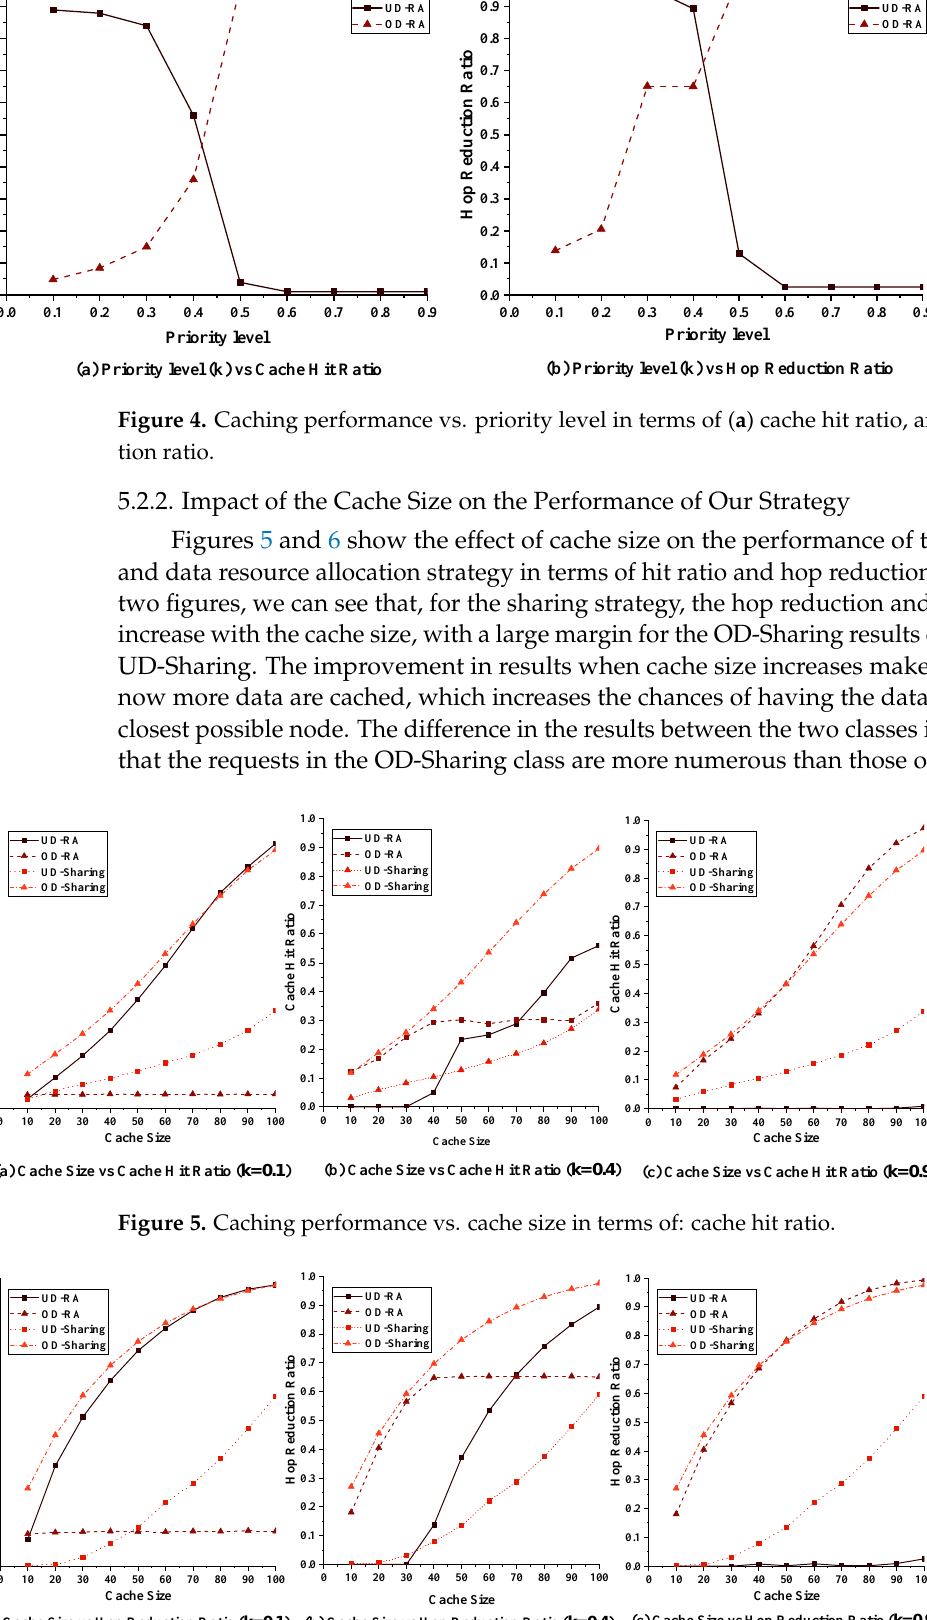
Figure 6. Caching performance vs. cache size in terms of hop reduction ratio when varying k